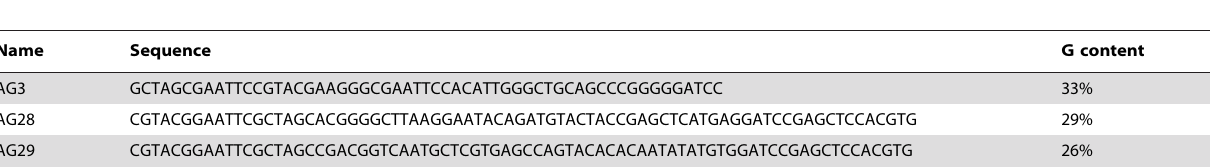
Table 1. Summary of aptamer